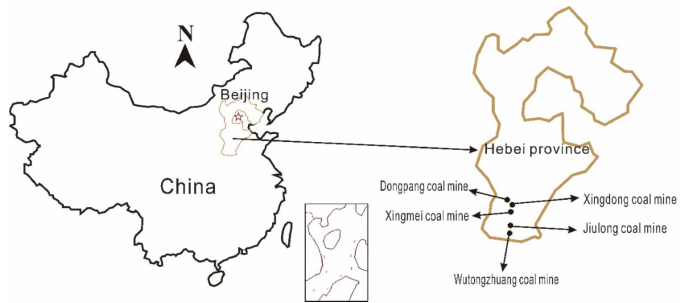
Figure 1. Distribution map of some of the coal mines in the study area. Table 1. Number of boreholes with different depths and drilling flushing fluid consumption at the upper layer of the MOL and the average of drilling flushing fluid consumption at corresponding depths (Dongpang